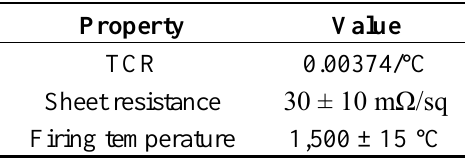
Table 4. Properties of platinum